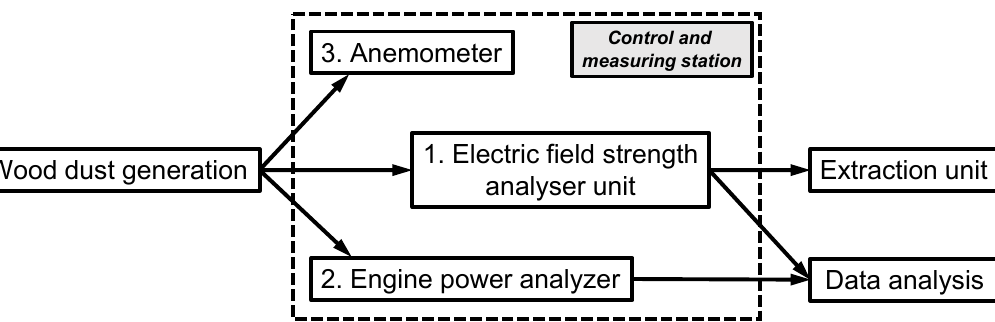
Figure 4. Experimental control and measuring setup.